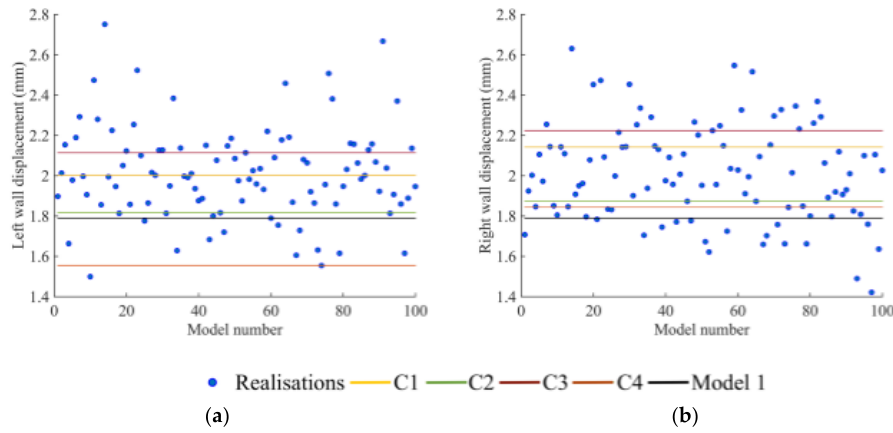
Figure 11. Representation of the displacements (in mm) obtained for all of the analysed models (102), the deterministic model 1, cluster 1 (C1), 2 (C2), 3 (C3), and 4 (C4) of model 2, and the 100 realisations, in: ( a ) the centre of the left sidewall; and ( b ) the centre of the right sidewall. Note that all of the previously presented values were obtained after the tunnel’s total excavation and in the same section of the tunnel, with a value equal to 0. Figure 12 shows the displacements